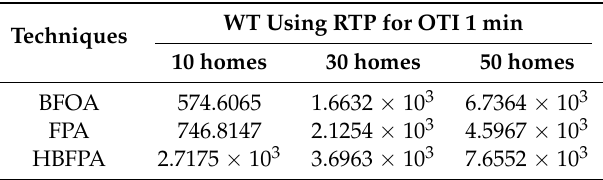
Table 16. Waiting time for 24 h (for multiple